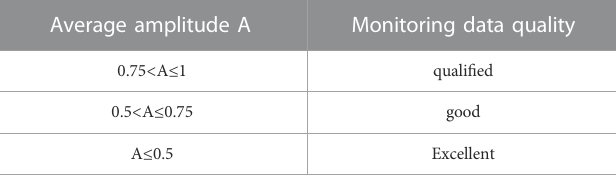
TABLE 1 Judging conditions of station background. Average amplitude